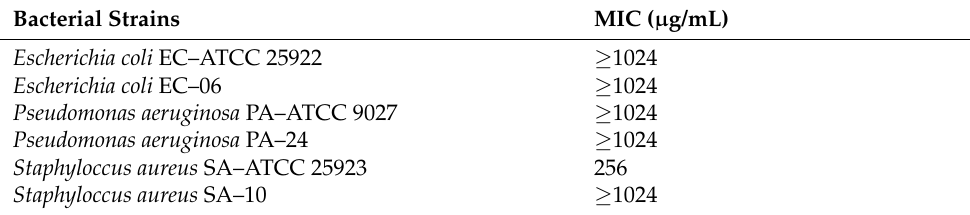
Table 3. Results of MIC ( µ g/mL) in the presence of A. heterophyllus fixed almond oil. Bacterial